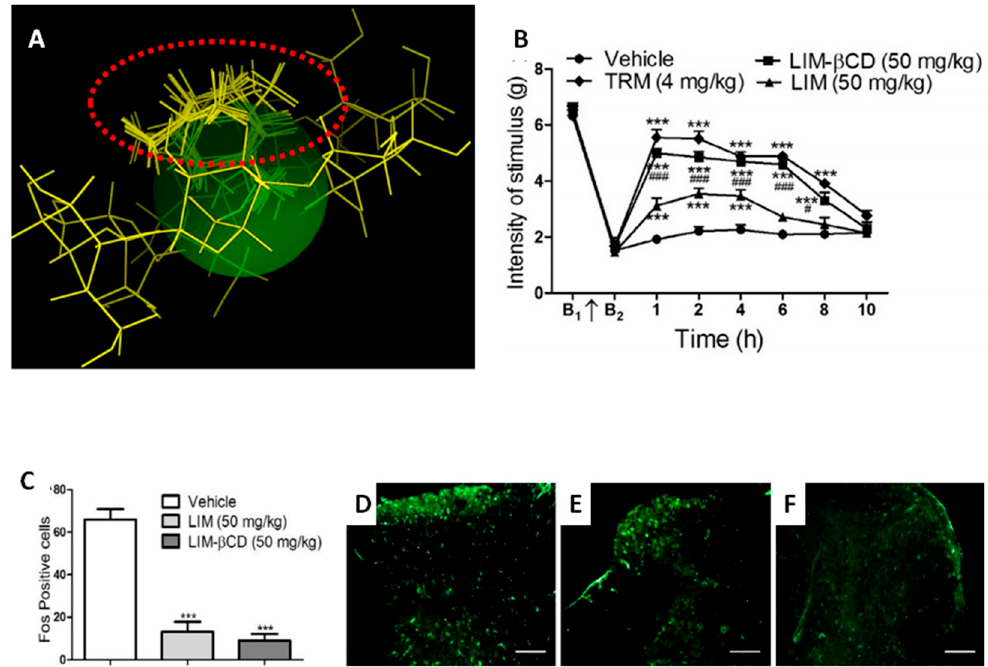
Figure 4. ( A ) Ten possible interactions of limonene (LIM) and CDs obtained through molecular modeling. The green space represents the CD cavity; ( B ) Response time evaluation after administration of vehicle, LIM (50 mg/kg), LIM- β CD (50 mg/kg) or TMR (4 mg/kg) on mechanical hyperalgesia induced by acidic saline in mice. The values are expressed as mean ± SEM. * p < 0.05, ** p < 0.01 or *** p < 0.001 vs. Control group. # p < 0.05, ## p < 0.01 or ### p < 0.001 vs. LIM group (two-way analysis of variance ANOVA followed by Bonferroni test); ( C ) Fos-positive cells in the lumbar spinal cord. Vehicle ( D ), LIM (50 mg/kg) ( E ), LIM- β CD (50 mg/kg) ( F ) were administered 60 min before perfusion. The values are expressed as mean ± SEM ( n = 6, per group). *** p < 0.001 vs. control group (one-way ANOVA followed by Bonferroni test) [42]. Scale bar: 20 µ